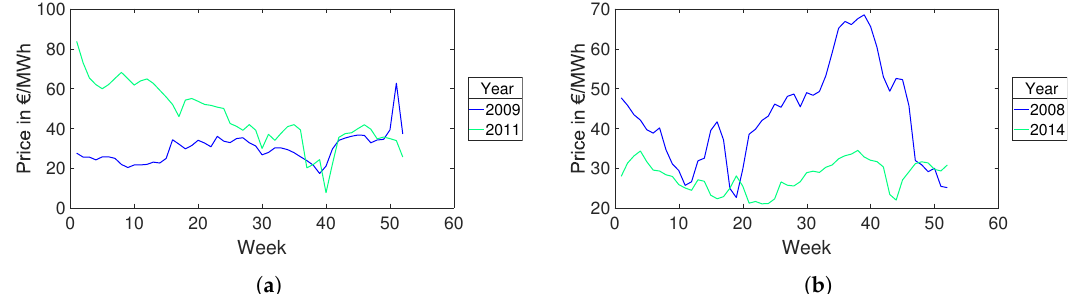
Figure 12. Weekly historical Norwegian power market prices. ( a ) Years 2009 and 2011; ( b ) Years 2008 and 2014.